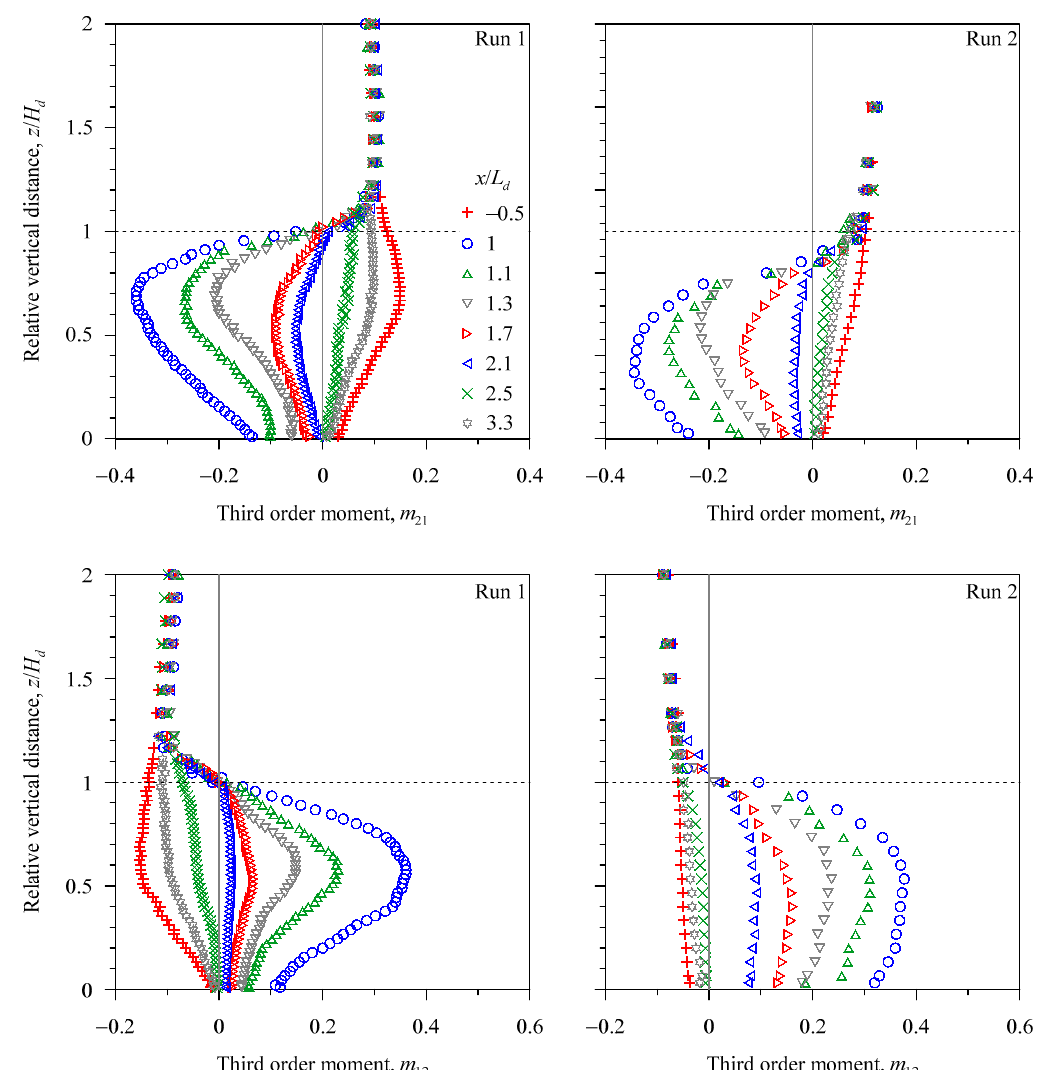
Figure 8. Vertical profiles of third-order moments m 21 and m 12 at various relative streamwise distances x / L d in Runs 1 and 2.